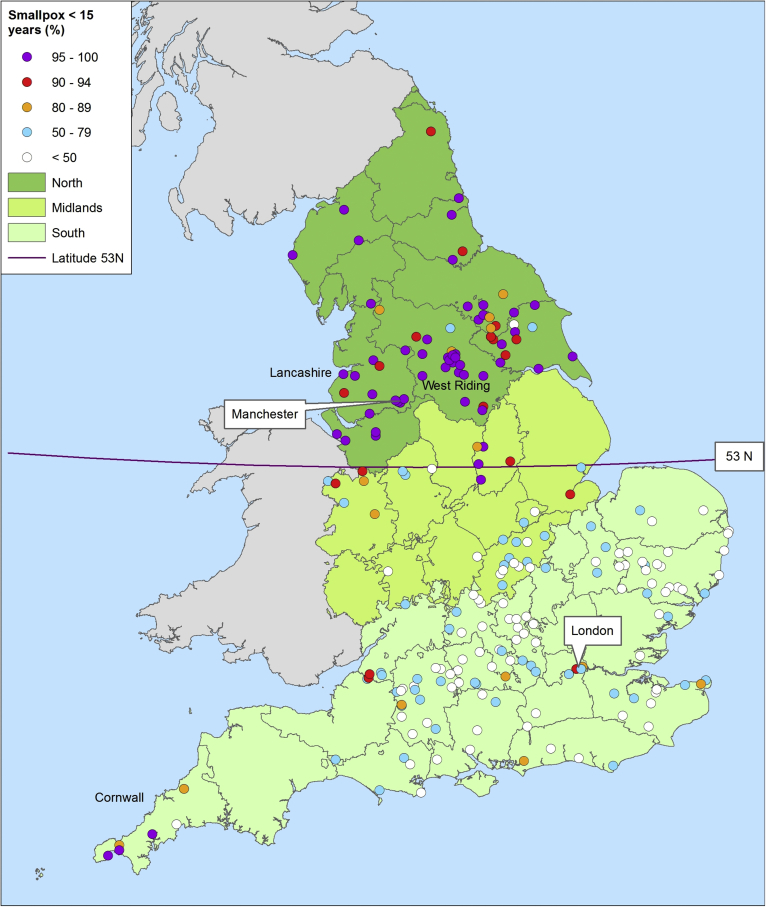
Percentage of smallpox victims aged under 15 years by place, and English regions. Notes: Divisions represent county borders. Sources: see Table S1.